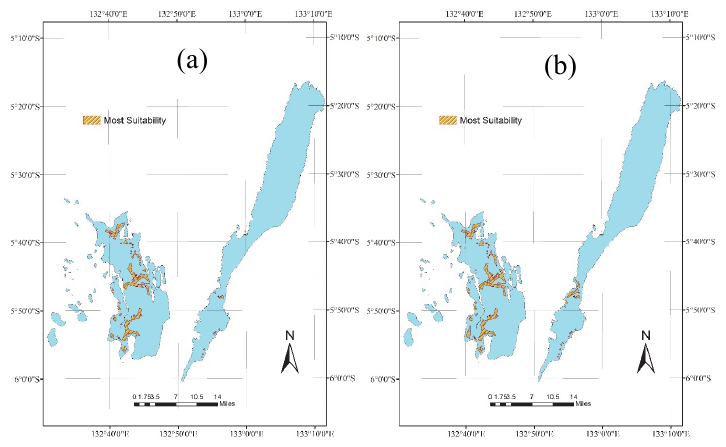
Fig. 7. Suitability parcels with restriction: (a) AHP; (b) Fuzzy AHP